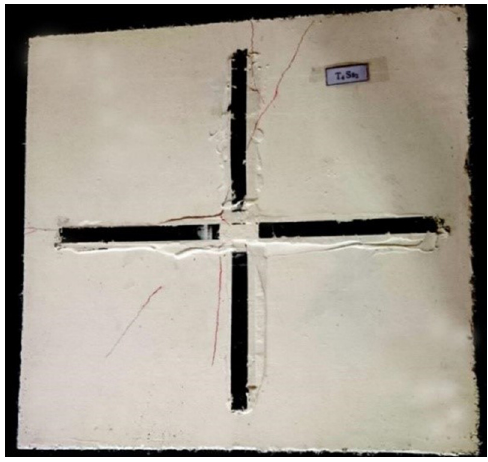
Figure 9: Crack pattern of the slab T4SS2 under impact loading.